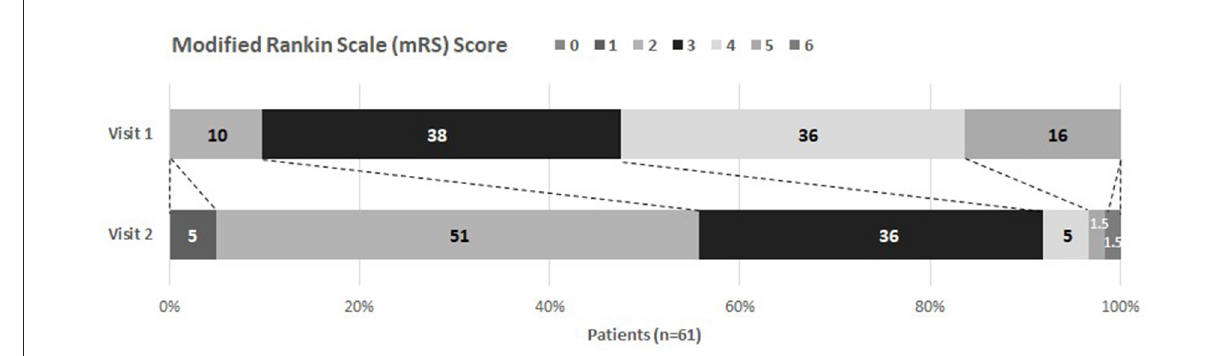
FIGURE2 Modified Rankin Scale at visit 1 and 2. Visit 1 took place at study inclusion, visit 2 at discharge from inpatient care. Percentages of each category are given. A shift of mRS values can be noticed (depicted with dotted lines) showing improvement between visits.